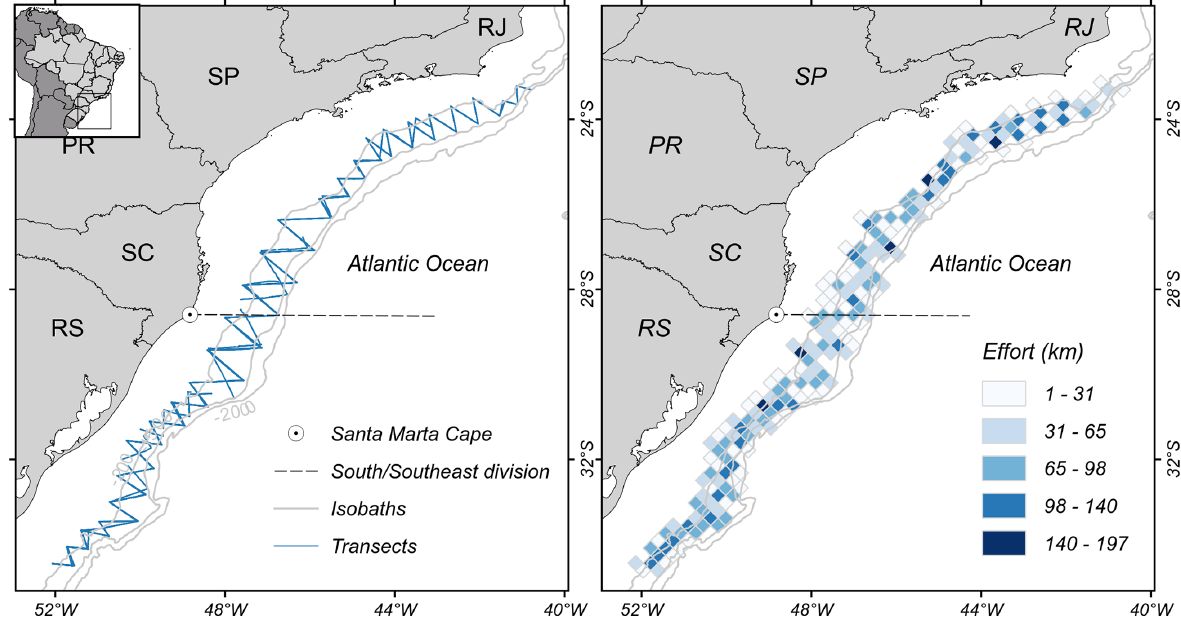
Fig 1. Ship-based cetacean survey tracks and effort in outer continental shelf and slope off southern and southeastern Brazil between 2009 – 2014. A) Zig-zag transects lines followed by the ship. B) Grid cells are 0.25°x0.25° and darker shading indicates greater searching effort. Acronyms represent the Brazilian states of Rio Grande do Sul (RS); Santa Catarina (SC); Paraná (PR); S ã o Paulo (SP) and Rio de Janeiro